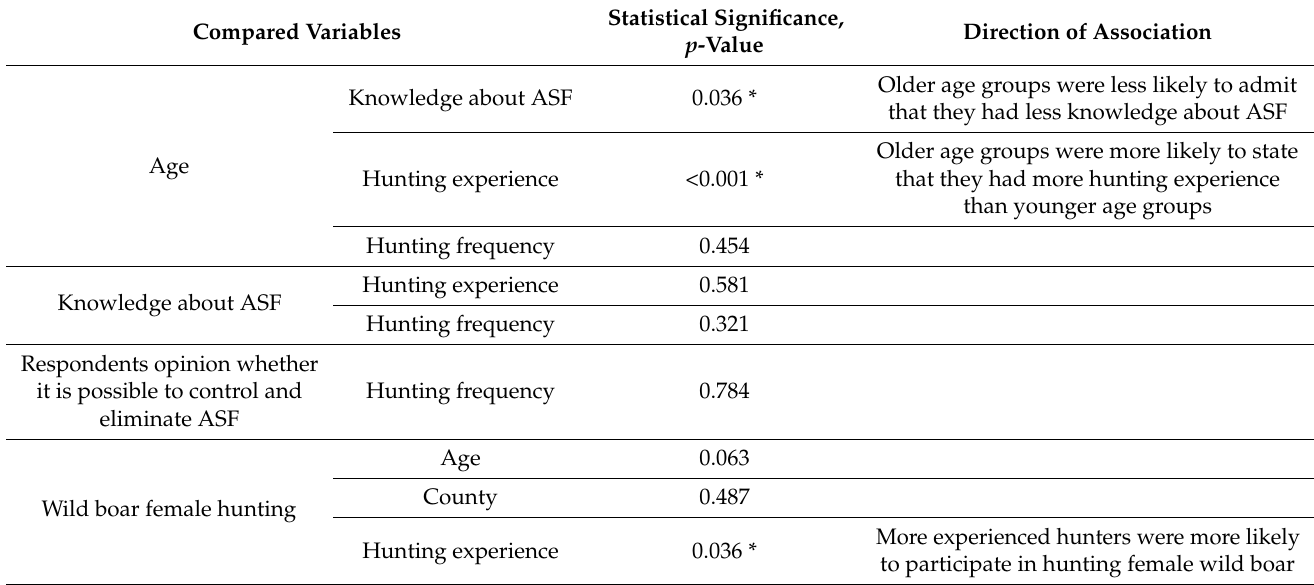
Table A2. Univariate analysis results of explored